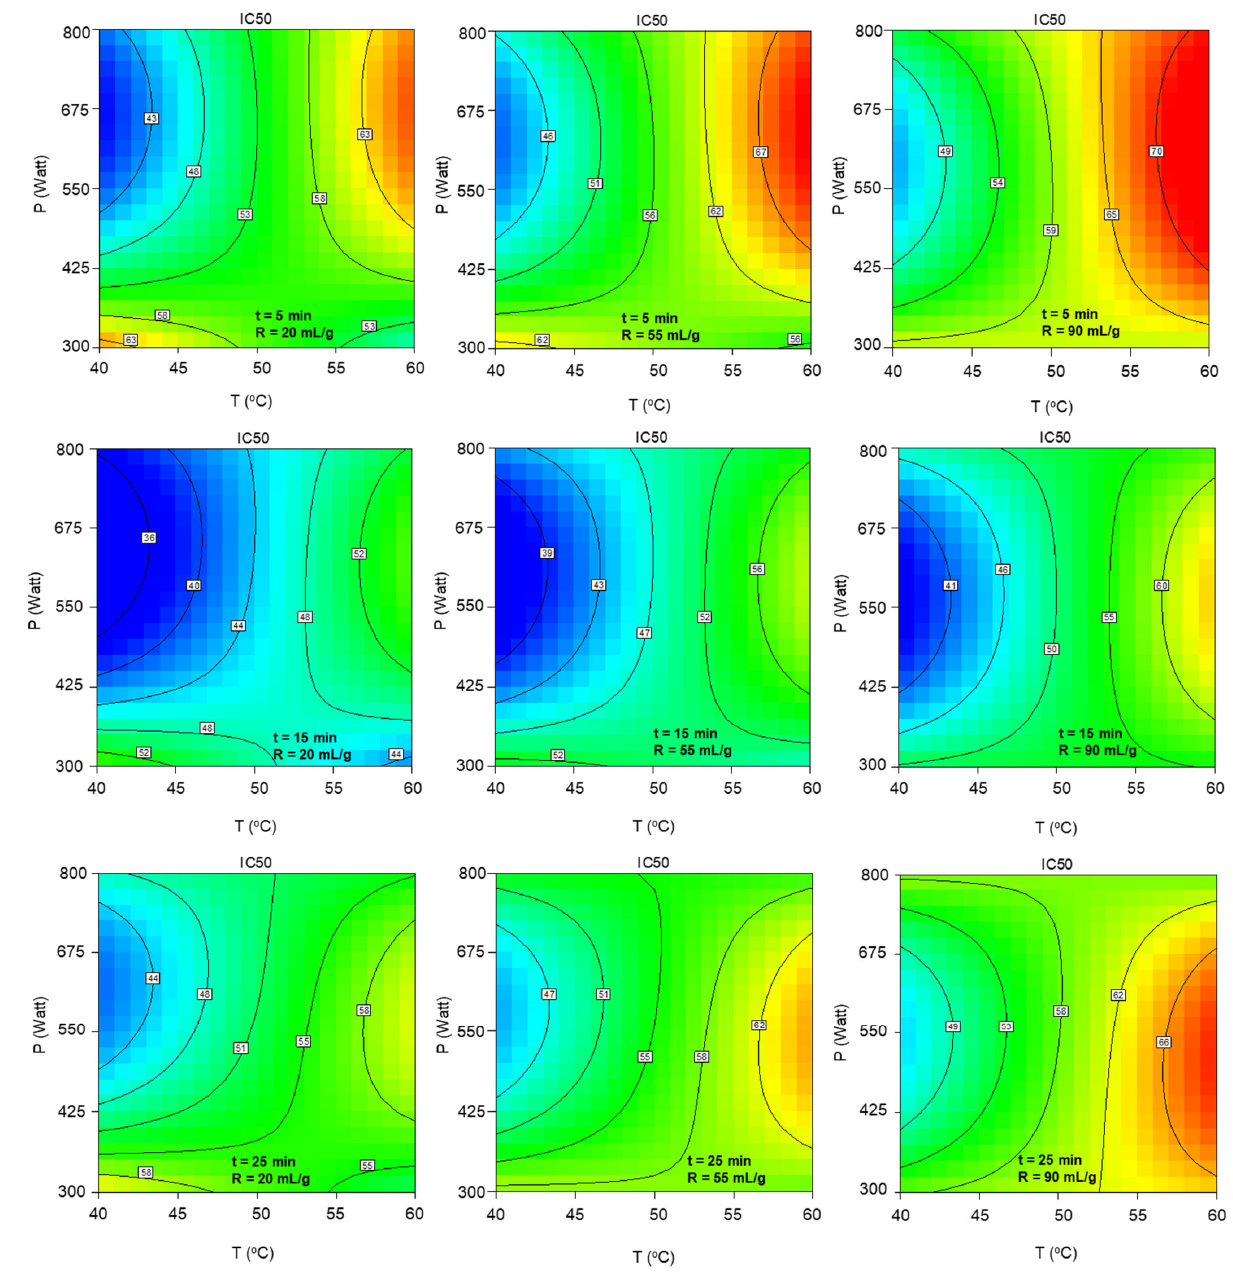
Figure A4. Contour plots of extract’s antioxidant activity indicator, IC 50 , as a function of extraction temperature and microwave power at the low, central and high levels of extraction duration and solvent ‐ to ‐ biomass ratio.